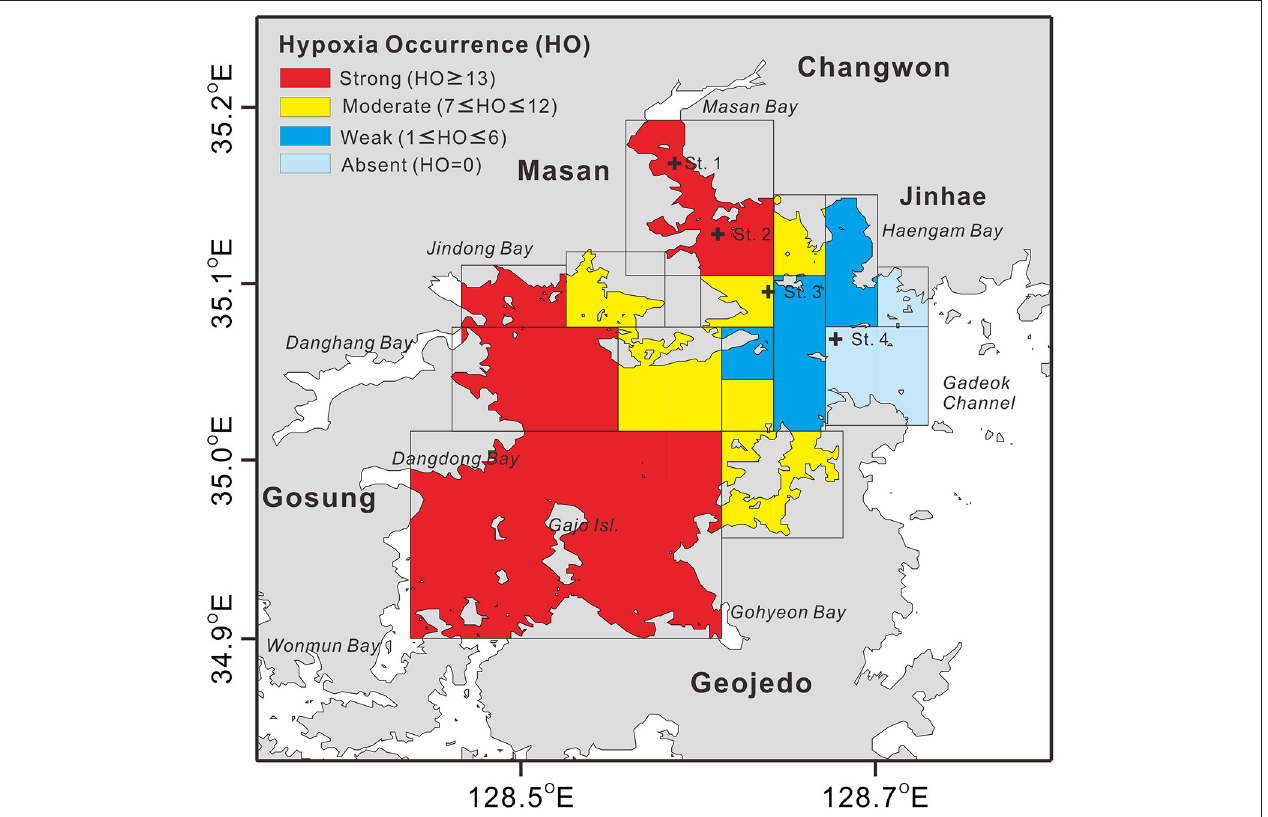
FIGURE 2 | Spatial distribution of the counted numbers of hypoxia occurrence (HO) from a total of 16 surveys conducted during the month of August 1990–2016 in the Jinhae Bay. The data sources are Kim and Lee (1994), Kim S.-Y. et al. (2012), and annual National Institute of Fisheries Science (NIFS) reports (http://www.nifs.go. kr/bbs?id=seastate). Plus signs ( + ) represent the locations of benthic community sample collection (see Figure 5 ). Note that here HO was determined with the criterion of dissolved oxygen < 3mg L − 1 in Figure 2 as the compiled maps showing hypoxia distributions in the Jinhae Bay from the previous studies were mostly based on the criterion of dissolved oxygen < 3mg L − 1